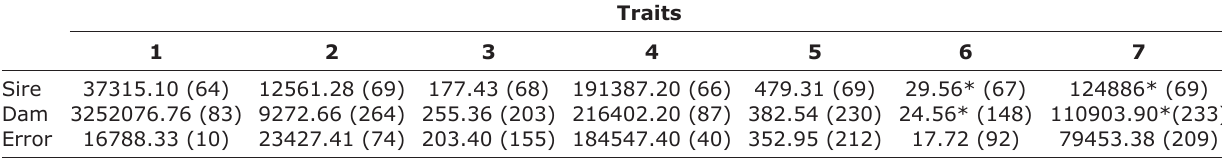
Table-2: Mean square values of production and reproduction traits of broiler breeder poultry.